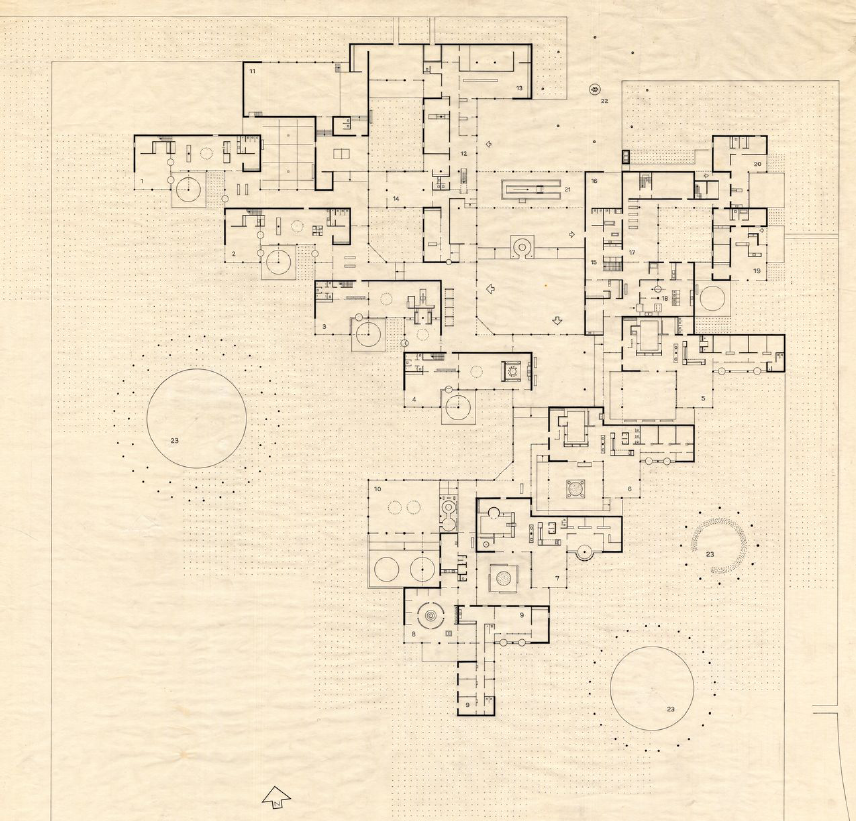
Aldo van Eyck, Children’s Home, ground floor plan. From: Francis Strauvan. Aldo van Eyck. The Shape of Relati- vity. Amsterdam: Architectura & Natura,